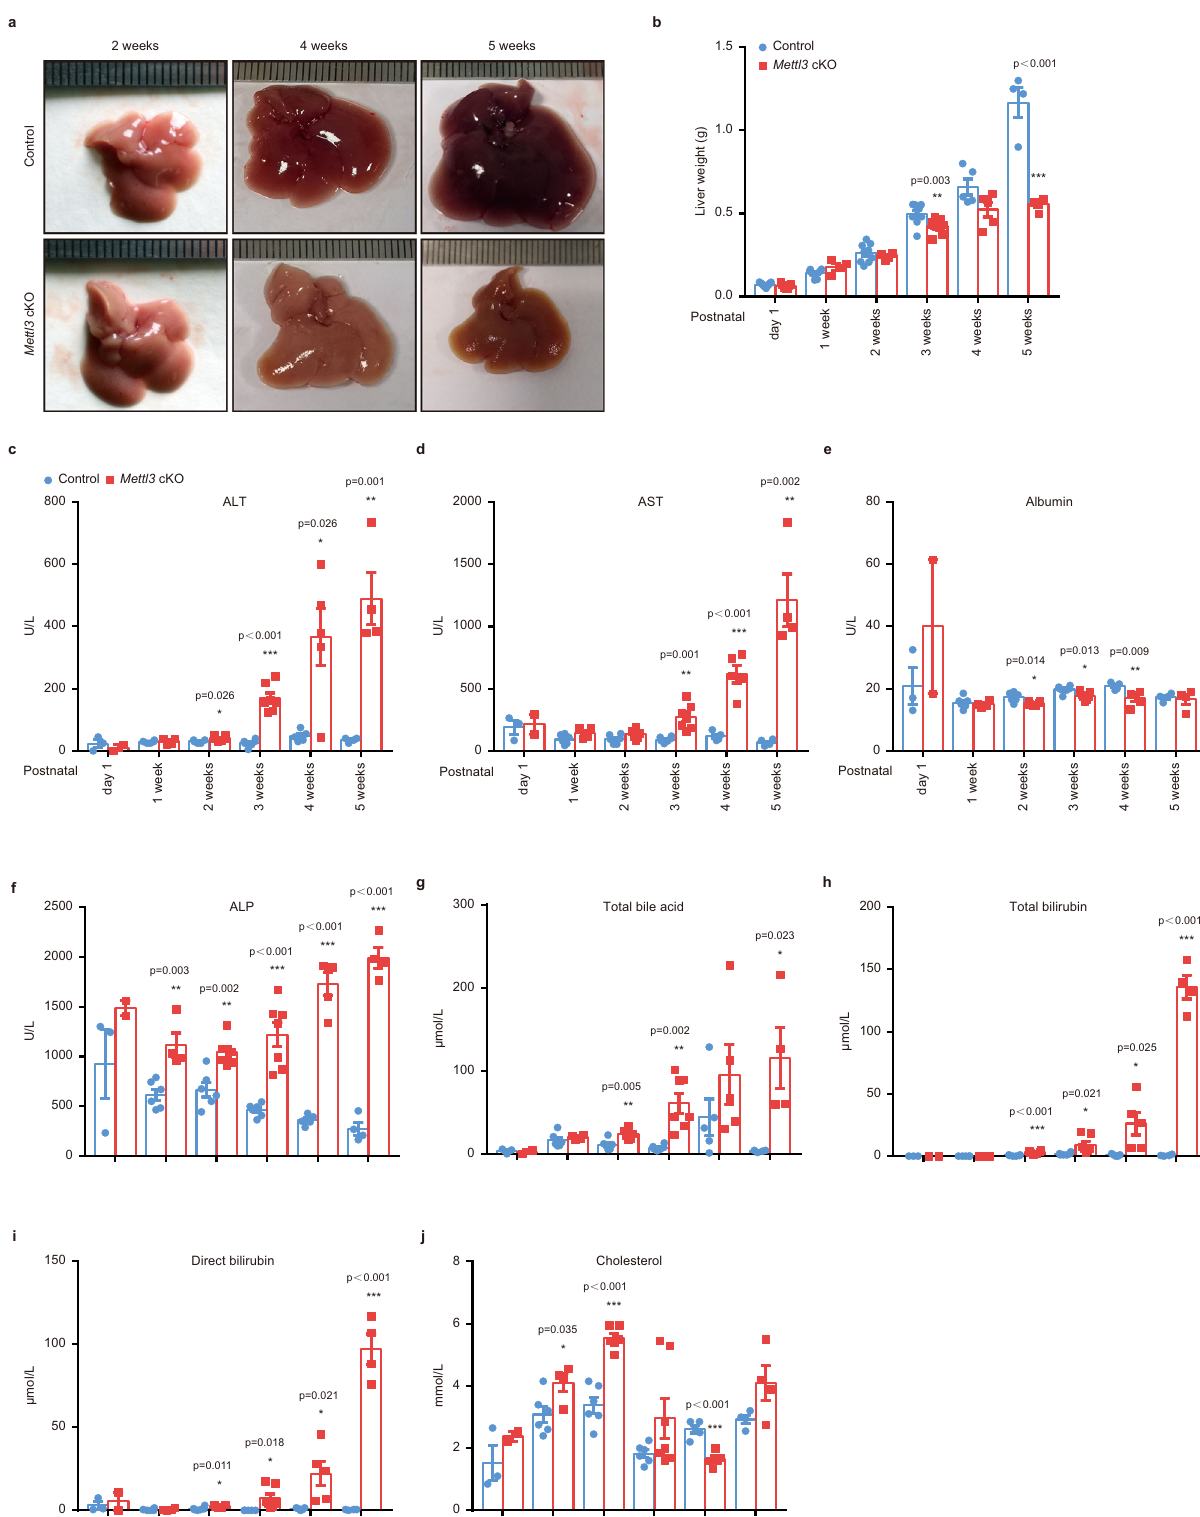
e , ALP f , Total bile acid g , Total bilirubin h , Direct bilirubin i , and Cholesterol j of Controland Mettl3 cKOmiceatdifferenttimepointspostnatally( n =2forday1cKO group; n =3forday1Controlgroup; n =4for1weekcKOand5weeksgroups; n =5 for 4 weeks groups; n =6 for 1 week Control group, 2 weeks groups, and 3 weeks Controlgroup; n =7for3weekscKOgroup).Datain b – j wereshownasmean±SEM with the indicated signi fi cance (* P <0.05, ** P <0.01, *** P <0.001, two-tailed stu- dent ’ s t -test). Source data are provided as a Source Data fi